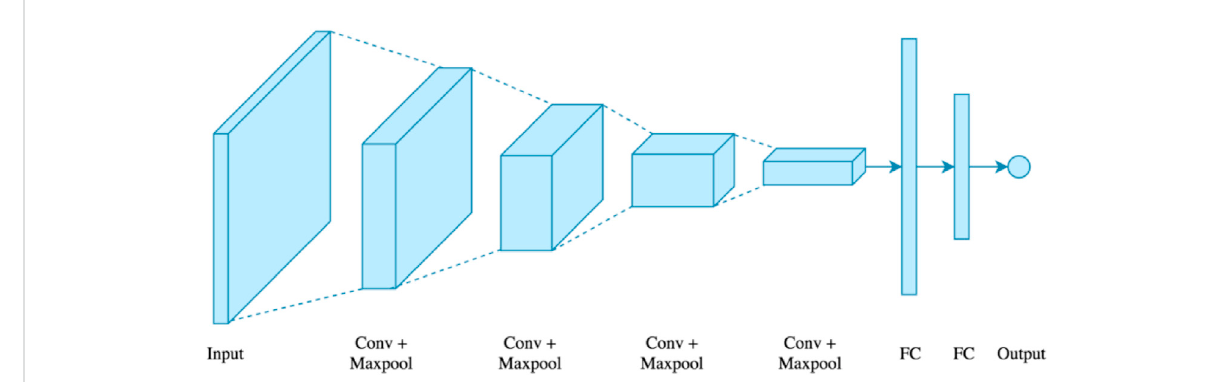
FIGURE 6 (cid:129) Long Short-Term Memory (LSTM) Network: Hochreiter and Schimdhuber collaborated to create the LSTM Convolutional neural network. (Lecunet al, 2015), which is utilizedin various applications. LSTMs werechosen byIBM primarily for voice recognition. The LSTM employs amemory unit known as a cell that may retain its value for an extended period and aids the device in remembering the most recent computed value. The memoryunit,alsoknownasacell,comprisesthreegatesthatregulatethemovementofdatainsidetheunit.Figure7showsthelogicalstructure of a LSTM model.